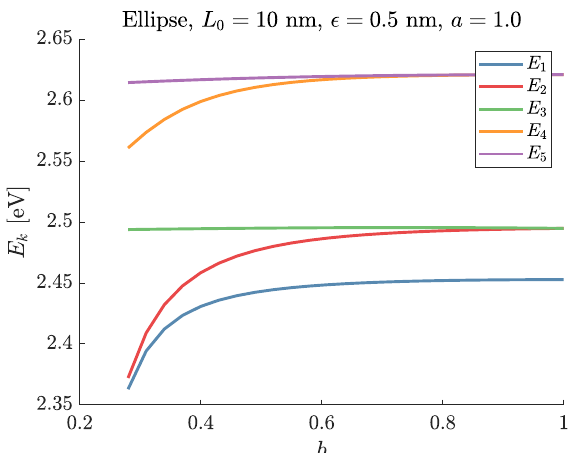
Figure 7. Eigenvalues for the closed ellipse with length 10nm and constant with